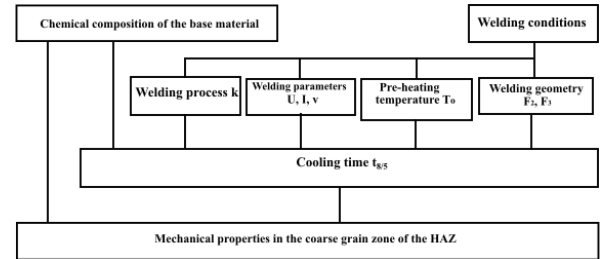
Figure 2: Parameters that affect the mechanical properties of the CGHAZ. With the t cooling time between 800 and 500 ∘ C, F 8 / 5 weld factor for two or three-dimensional heat dissipation, k relative thermal eflciency, U, I (voltage and welding current). Reprinted with permission from Roos et al. // Heidelberg-Dordrecht. (2011). ©2011 Springer Verlag.